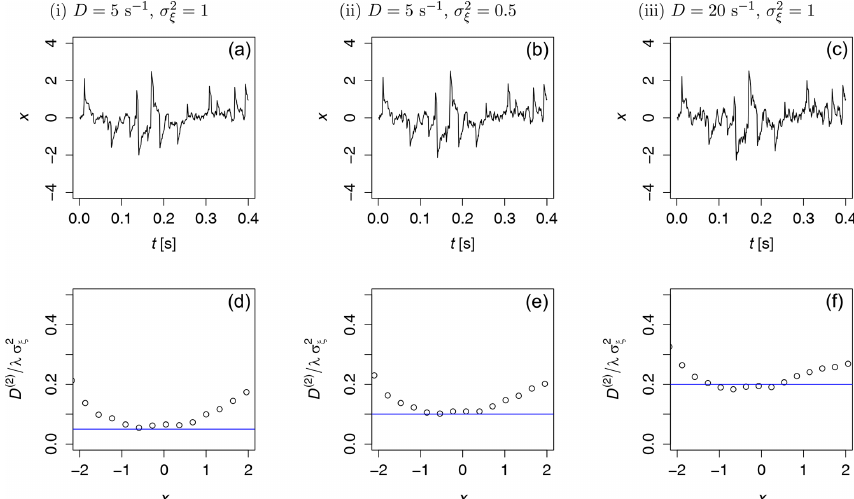
= 1; ξ = D (d, e, f) . λσ 2 ξ λσ 2 ξ